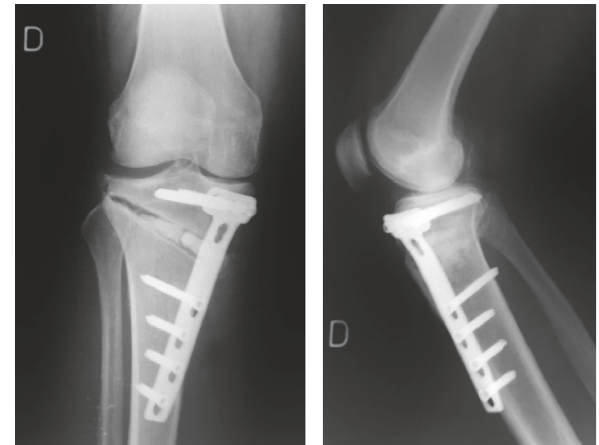
Figure 1: Preoperative weight-bearing X-rays showing narrowing of the joint space in the internal femorotibial compartment.